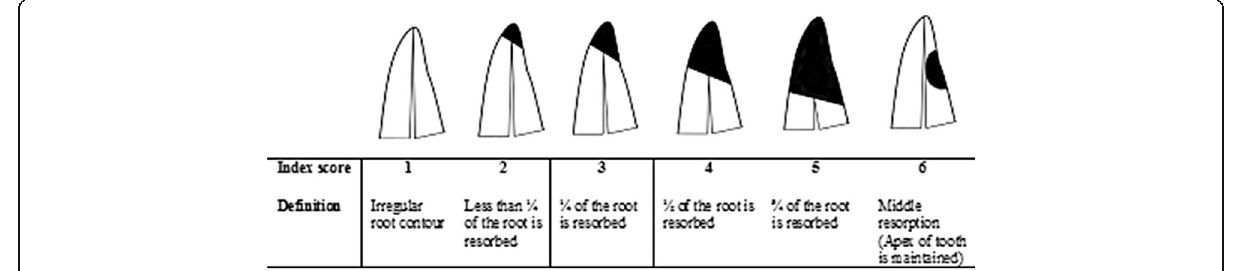
Fig. 3 Modified Malmgren classification of slanted root resorption with definition